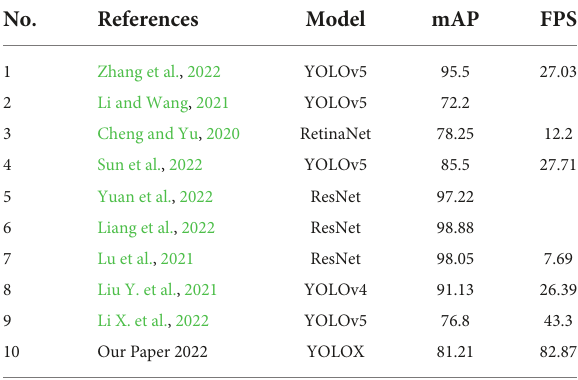
TABLE 3 Performance comparison for different network models on dataset